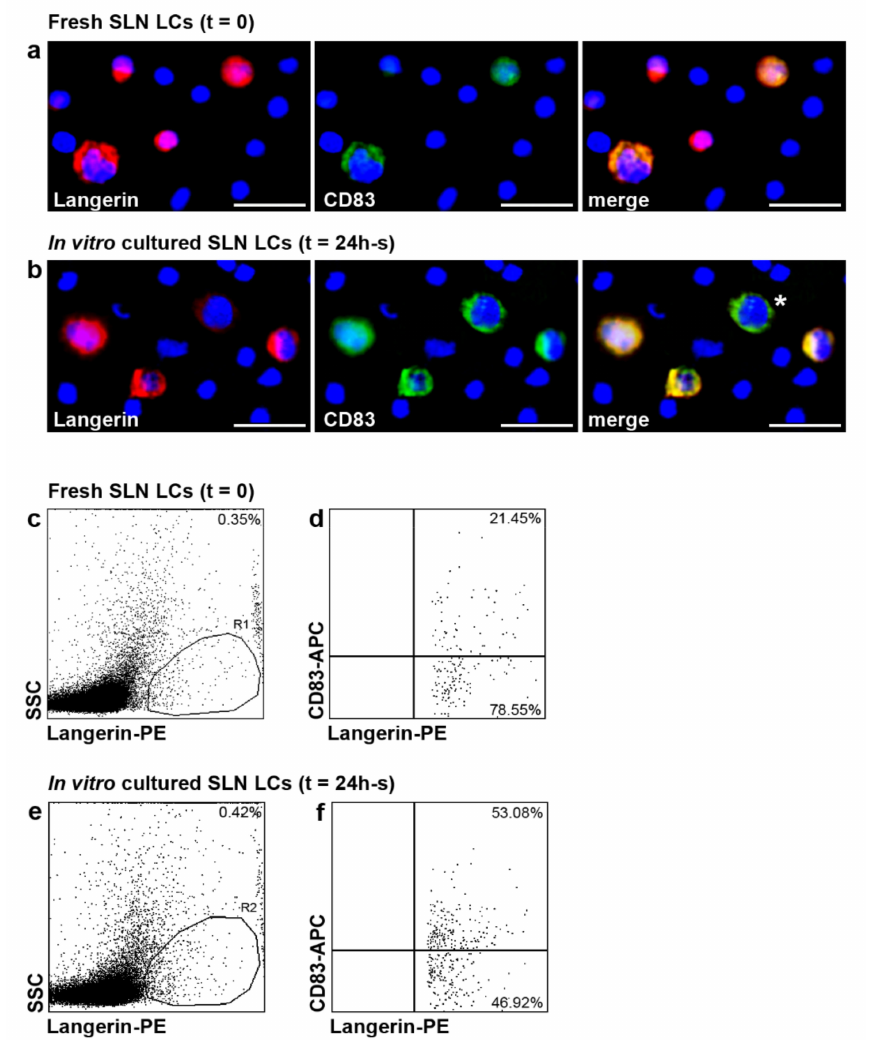
Figure 4. CD83 expression increased in SLN LCs from melanoma patients after in vitro